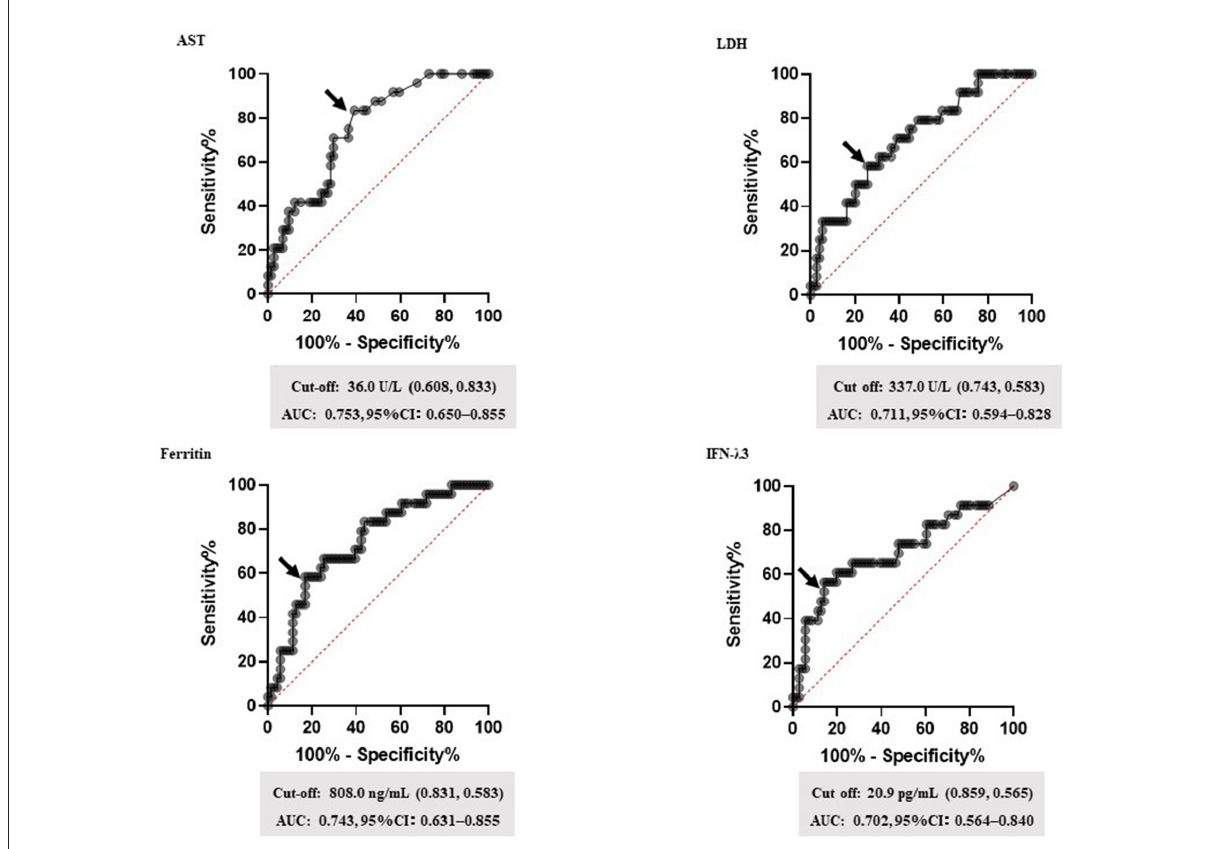
FIGURE2 The setting of biomarker cut-off values. Receiver operating characteristic (ROC) curves for the highest area under the curve (AUC) values are shown. ROC curves were analyzed to determine the cut-off values for each biomarker. The arrow indicates the cut-off point for each factor. Cut-off values (specificity and sensitivity), AUCs, and 95% confidence interval (CI) for each biomarker are shown. AST, aspartate transaminase; LDH, lactate dehydrogenase; IFN- λ 3, interferon lambda